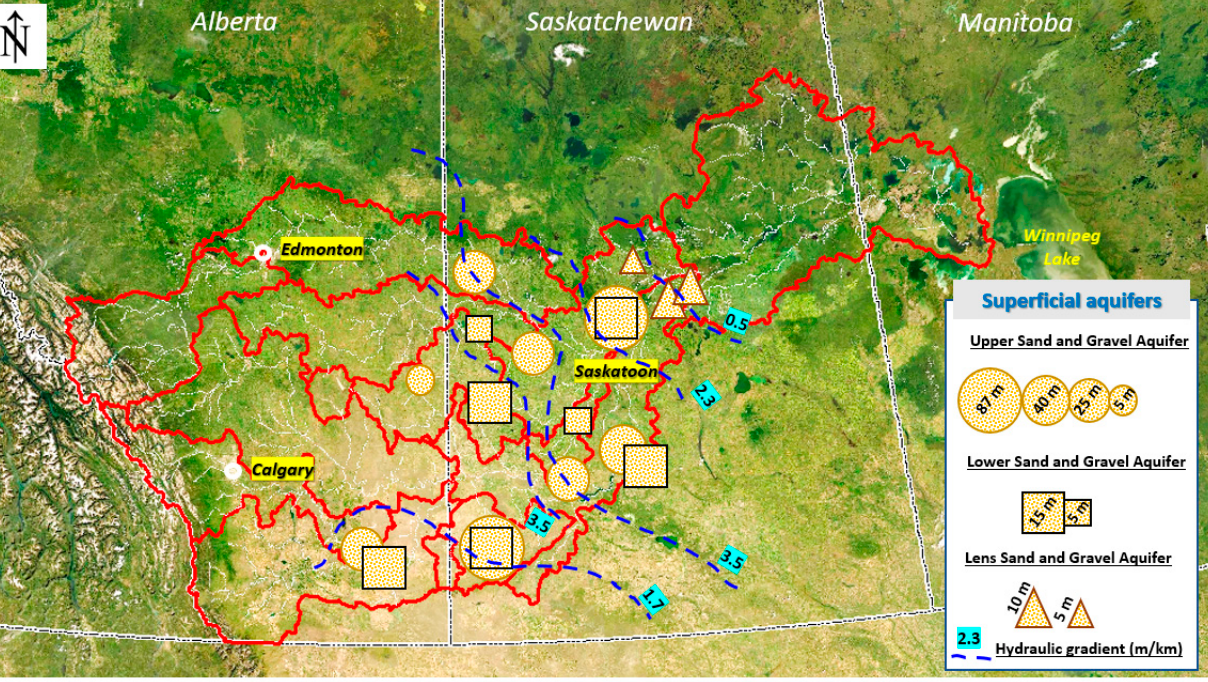
Figure 10. Spatial distribution of surficial aquifer thicknesses: circles and squares represent upper and lower sand and gravel aquifer thicknesses, respectively, while triangles represent aquifer lens thicknesses.